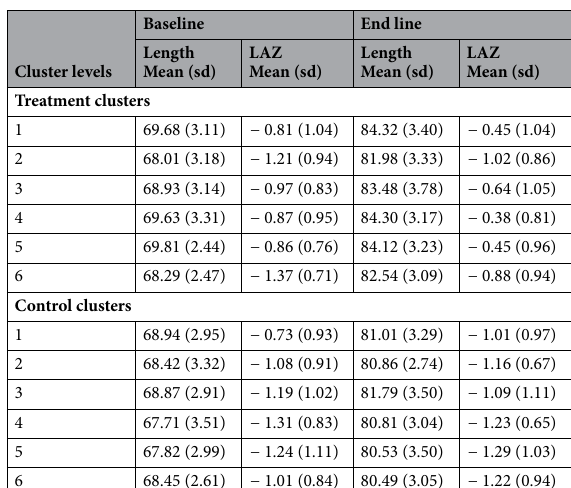
Table 2. Summary statistics of major outcomes at cluster level. Values are presented as mean ± SD.